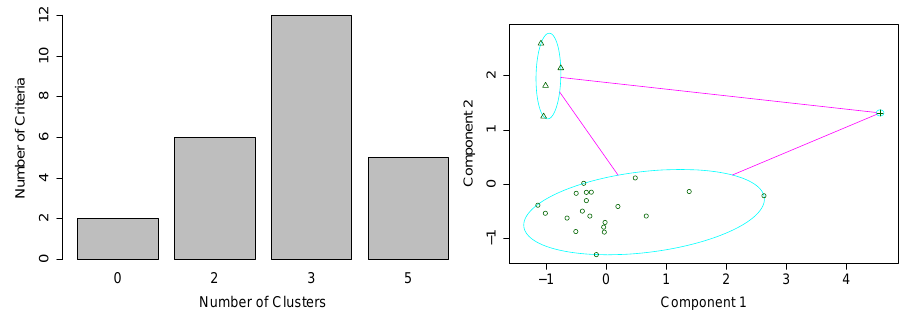
Figure 9. PAM result for the clustering analysis for the three parameters being τ lag,i , log t burst,i , and β Band . The histogram is the result of function NbClust, indicating the best cluster number is 3. The right panel shows the PAM result for the clustering analysis. The introduction of every parameter is in Section 2. The one outlier is 080319B. The four outliers are GRBs 080721A, 090926A, 091127A and 130408A.